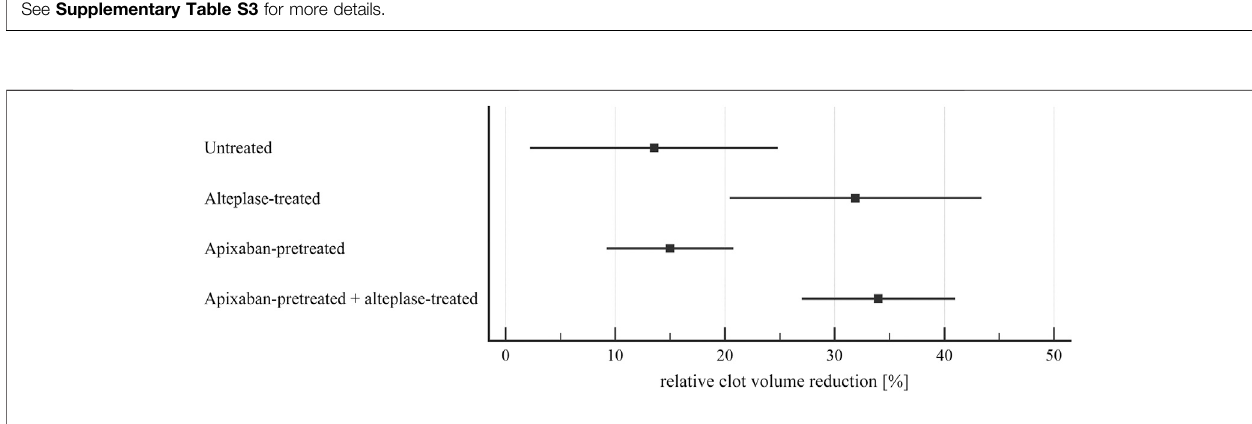
FIGURE5| Flowmodel:clotlysisexpressed asrelativeclotvolumereduction.Theforestplotshowsmeanvalues(square) and95%con fi denceinterval(whiskers). n (cid:1) 9 – 10.Resultsdemonstratethatalteplasetreatmentprovidedef fi cientthrombolysis,e.g.,documentedasgreaterclotvolumereductioncomparedtountreatedgroup (32 ± 15% vs. 14 ± 15%, p (cid:1) 0.02). For clots with and without apixaban, alteplase-induced lysis did not differ, e.g., clot volume reduction was 34 ± 10% vs. 32 ± 15%, p (cid:1) 1.00. See Supplementary Table S3 for more details.